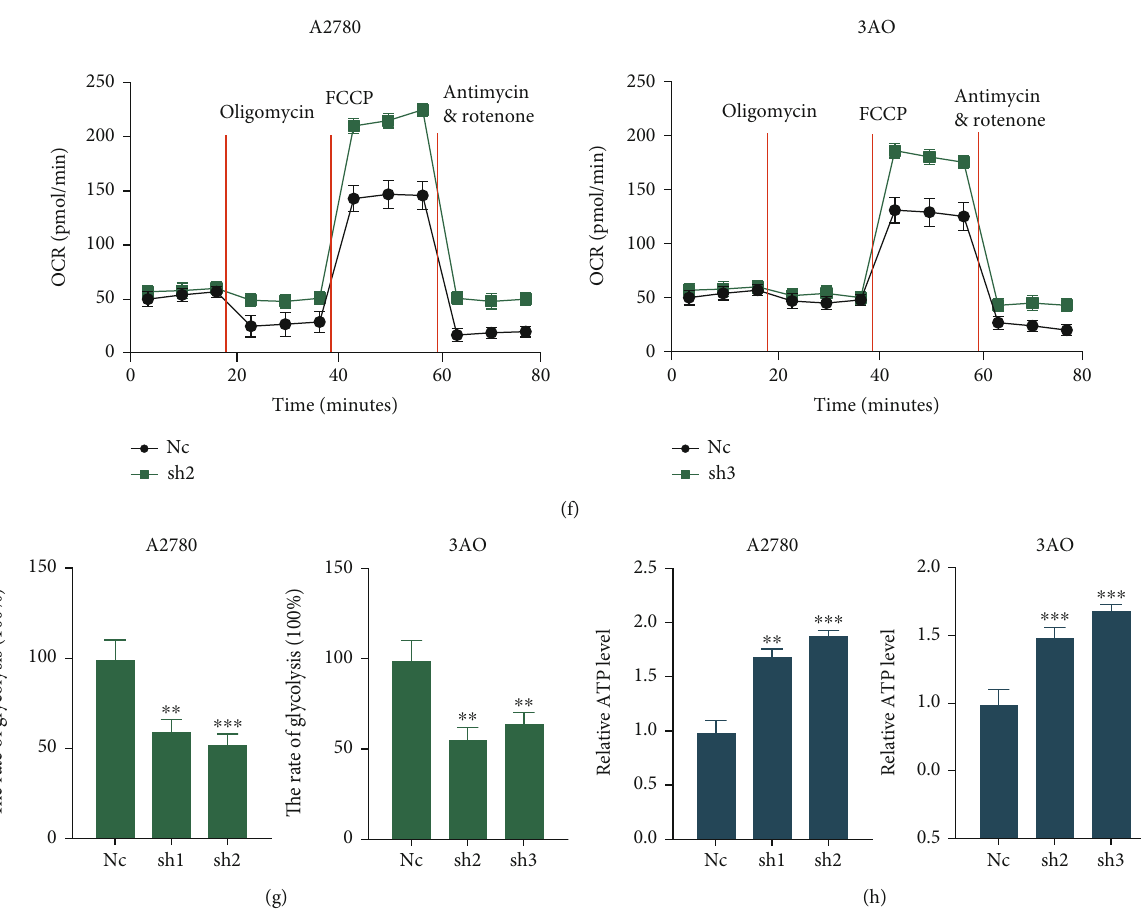
Figure 7: WTAP promotes the Warburg e ff ect in OC cells. (a and b) Alterations in lactate production (a) and pyruvate production (b) levels were analyzed after transfection of A2780 and 3AO cells with sh-NC, sh-WTAP in normal and hypoxia environment, ∗∗ P < 0 : 01 vs. NC group; ## P < 0 : 01 vs. Normal group. (c and d) Alterations in lactate production (c) and pyruvate production (d) levels were analyzed after transfection of HO8910 and OVCAR8 cells with NC, Lenti HIF-1 α , SI-WTAP reversing this e ff ect. ∗ P < 0 : 05 and ∗∗ P < 0 : 01 . (e) The extracellular acidi fi cation rate was analyzed after transfection of A2780 and 3AO cells with sh-NC, sh-WTAP. (f) The oxygen consumption rate was analyzed after transfection of A2780 and 3AO cells with sh-NC, sh-WTAP. (g and h) The glycolysis rate (g) and ATP level (h) were detected after transfection of A2780 and 3AO cells with sh-NC,